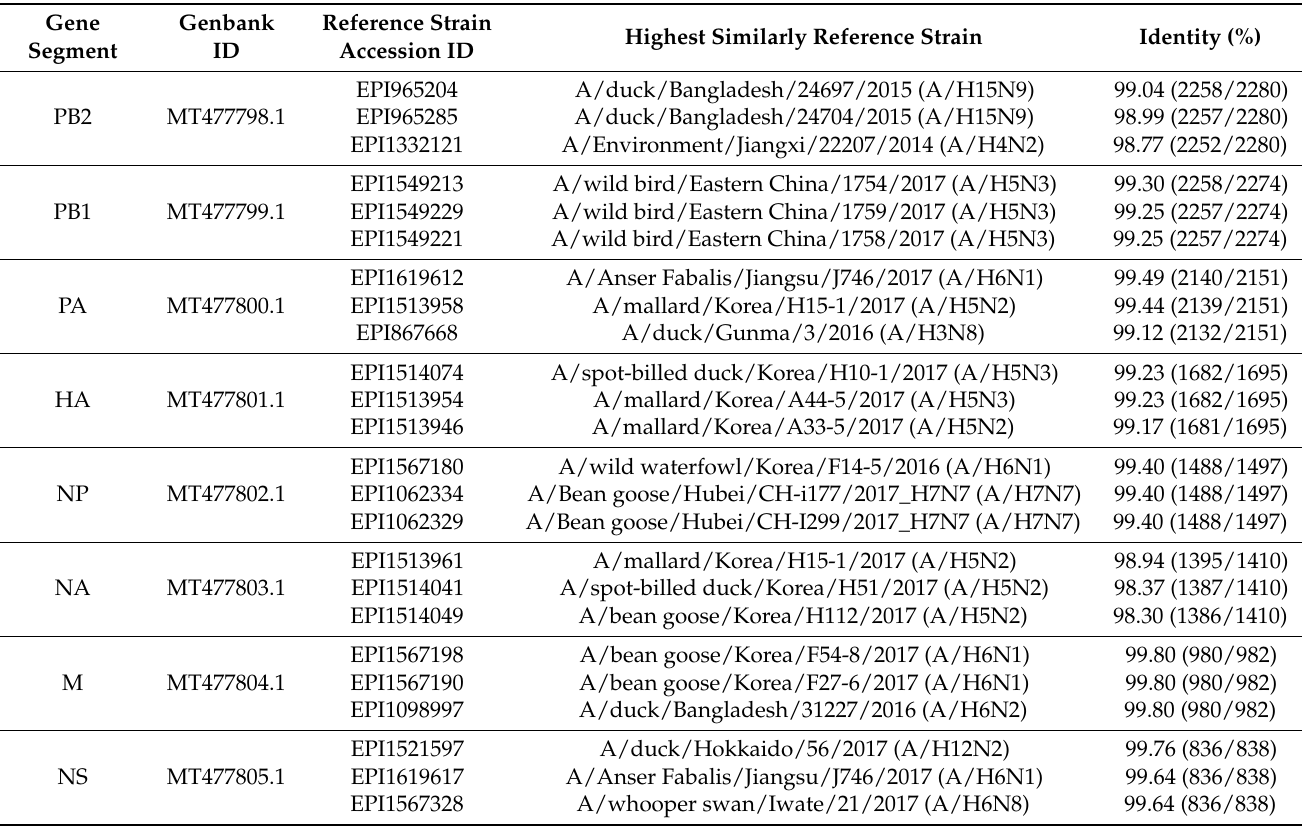
Table 3. Sequence homology of the whole A/Wild duck/South Korea/KNU18-93/2018 (A/H5N2)